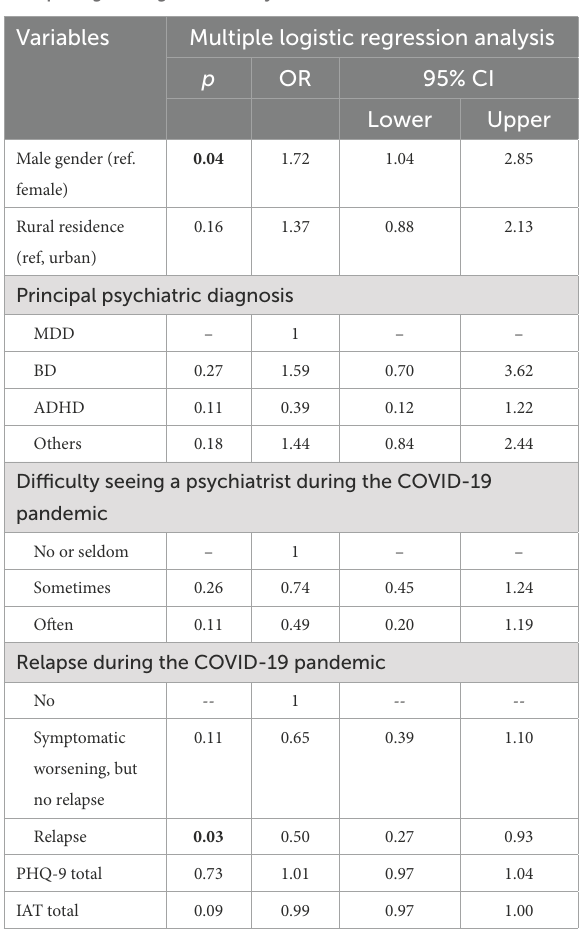
TABLE 2 Independent correlates of becoming a cyberbully victim by multiple logistic regression